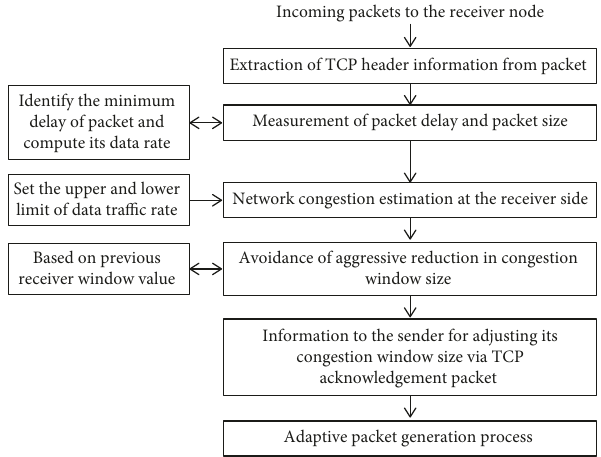
Figure 1: Overall proposed